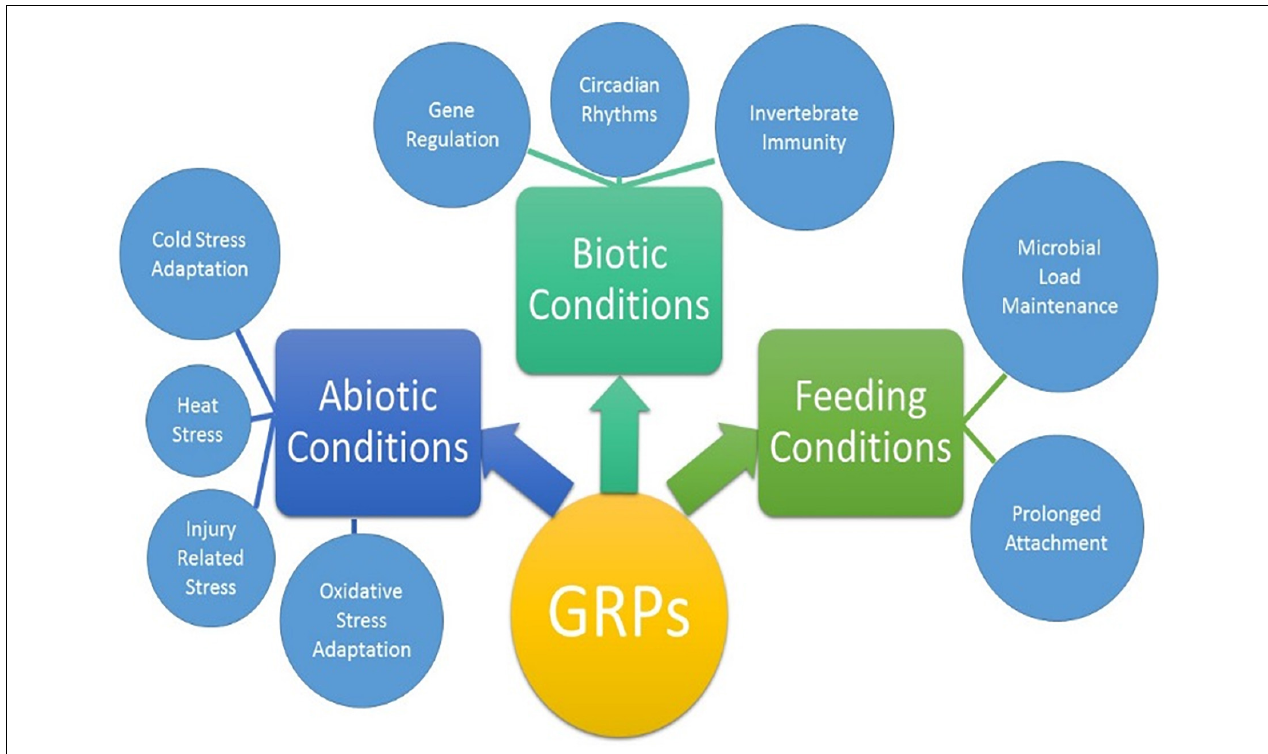
FIGURE 8 | Proposed biological activities of GRPs in tick biology. The extent of which each GRP participates in all listed physiological processes are not yet clear.